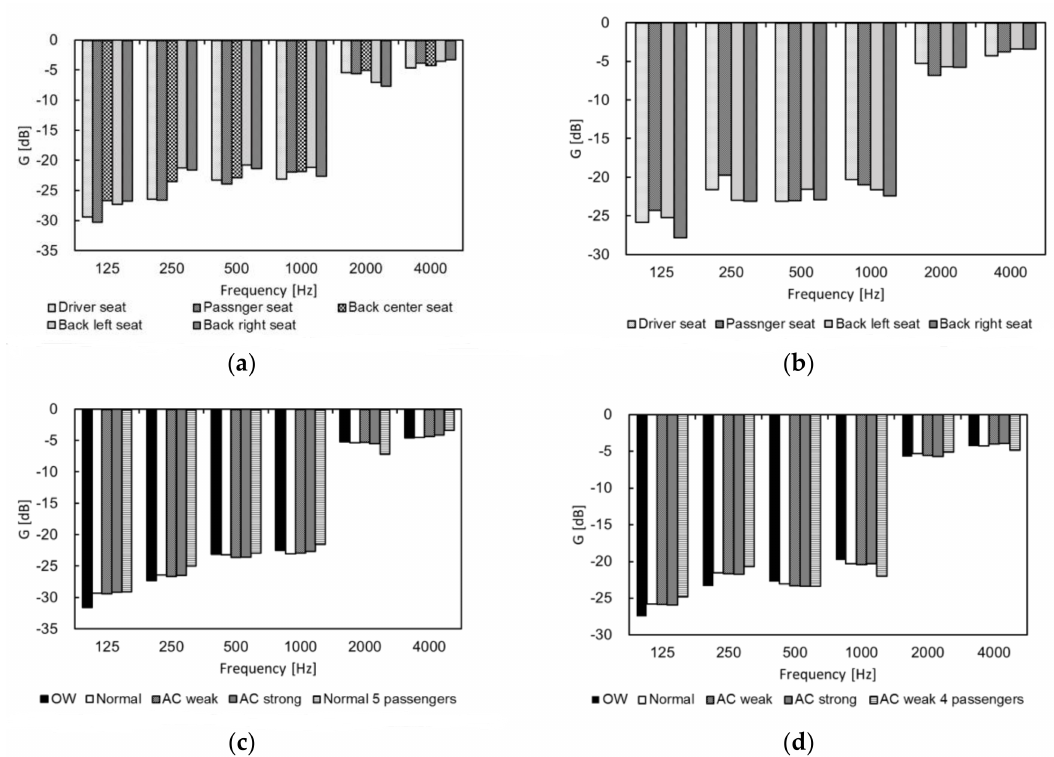
Figure 3. Measured G [dB] at each passenger position in cars ( a ) A and ( b ) B and under open-window (OW), air-conditioner (AC) and multiple passenger settings in cars ( c ) A and ( d ) B.